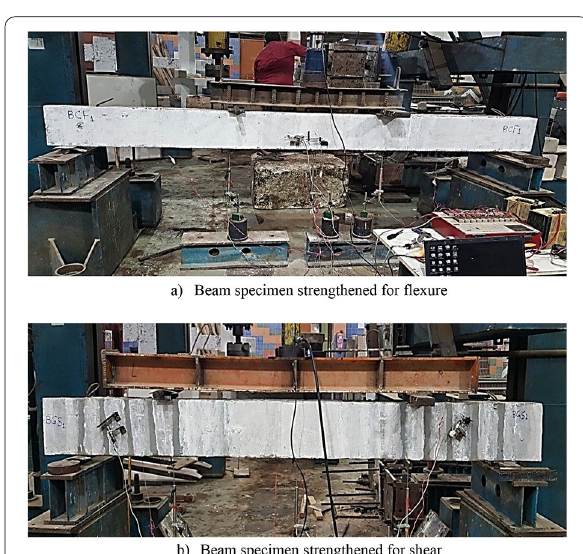
Fig. 6 Test setup and loading positions for test beam